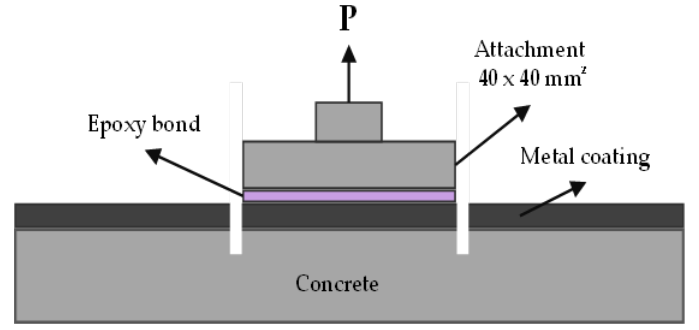
Figure 3. Diagram of bonding strength measurement.